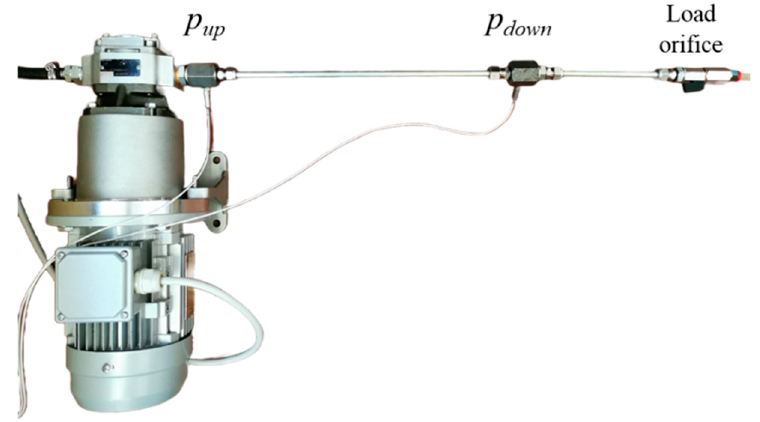
Figure 2. Tested pump and the delivery line (Configuration 3).